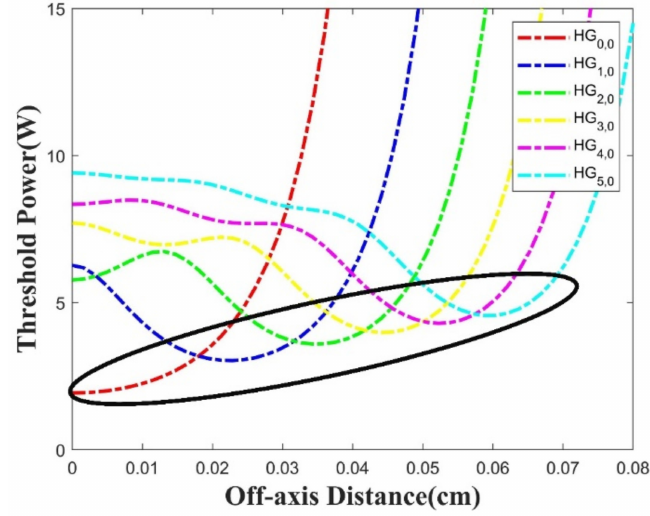
Figure 2. Threshold power vs. off-axis distance simulation curve of 6 modes ( σ 21 = 8 × 10 − 25 m 2 , l = 1.4 × 10 − 2 m, τ ef f = 14 × 10 − 2 s, v p = 3.787 × 10 14 s − 1 , N 0 = 4.13 × 10 26 m − 3 , n QY = 1.81, n a = 0.907, f = 0.319, δ =